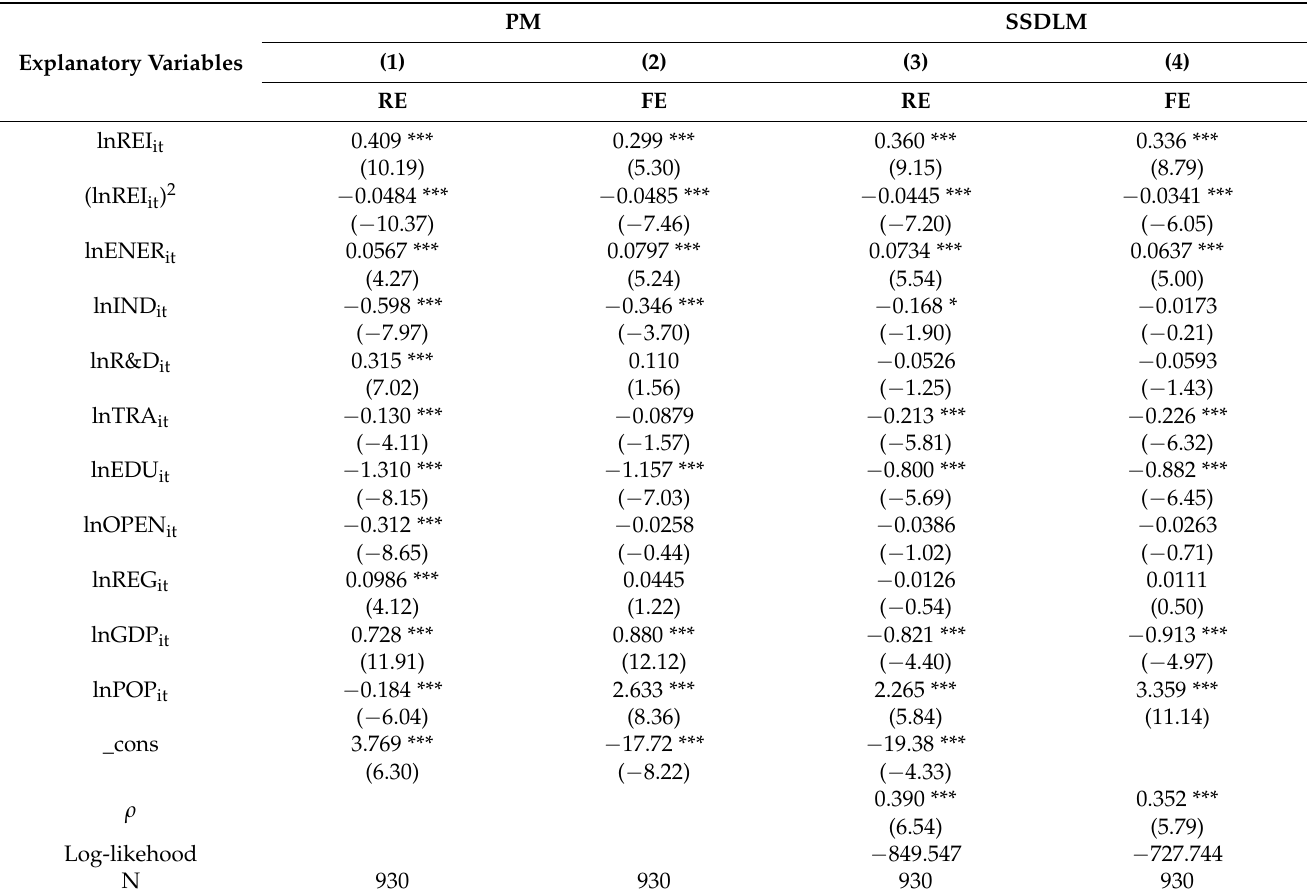
Table 3. Results of the